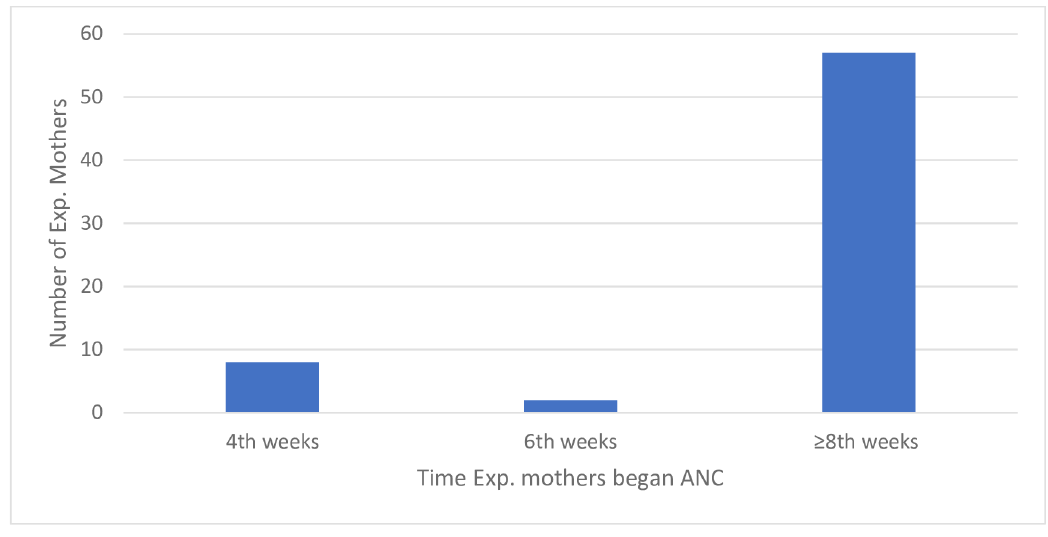
Fig 2. Time of first antenatal care